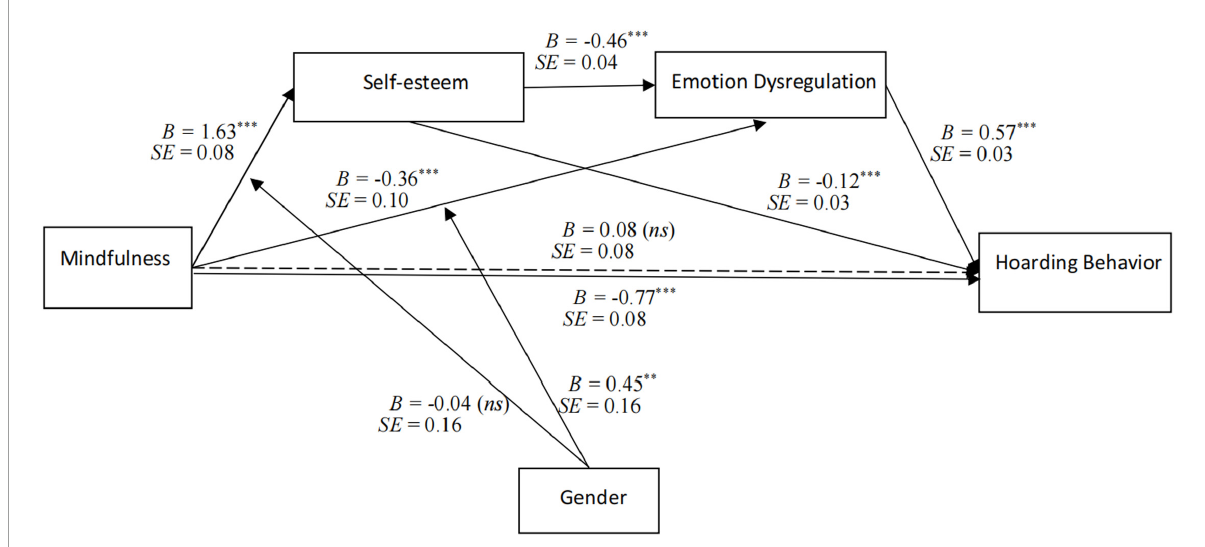
FIGURE2 Regression results of the moderated multi-mediation model. The model is assessed using PROCESS macro (MODEL6 and MODEL84). Dotted line represents the direct effect of mindfulness on hoarding behavior; the effects of age, education level, and income level are controlled; ns, non-significant; ∗∗ p < 0.01, ∗∗∗ p < 0.001.